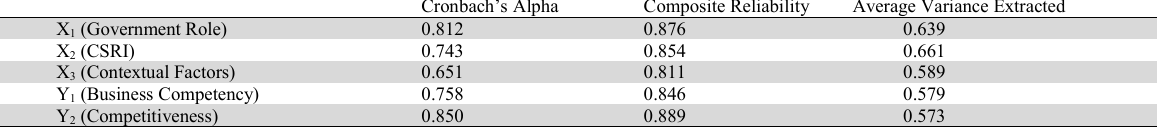
Cronbach's Alpha and Composite Reliability values, Average Variance Extracted (AVE)